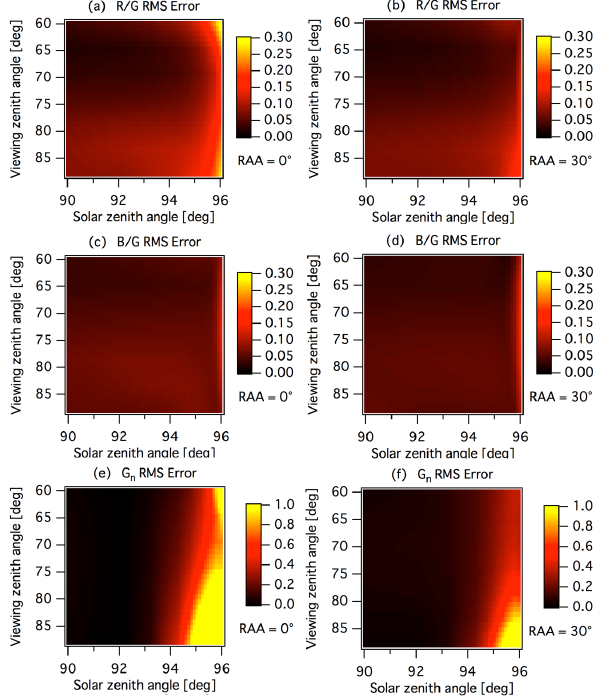
Figure 7. Forward model errors (absolute values) in (a, b) R / G, (c, d) B / G, and (e, f) G n caused by the model assumptions as functions of SZA and VZA (see text for details). Panels on the left (a, c, e) have RAA = 0 ◦ , and those on the right (b, d, f) have RAA = 30 ◦ .